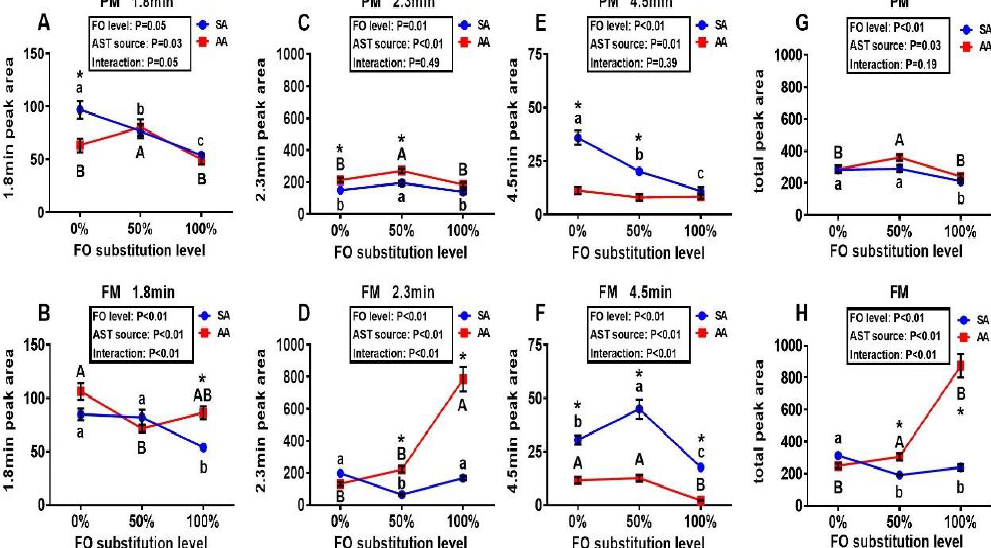
Figure 2. Effects of dietary fish oil substitution by DHA-rich microalgae and source of astaxanthin on relative areas of hepatic astaxanthin metabolite peaks ( A , B : 1.8 min; C , D : 2.3 min; E , F : 4.5 min; G , H : total of the three peaks) in juvenile rainbow trout fed the plant meal- (PM, A , C , E , G ) and fishmeal (FM, B , D , F , H )-based diets. Means labelled withdifferent letters [lowercase (a, b), synthetic astaxanthin (SA) groups; uppercase (A, B), microalgae astaxanthin (AA) groups] are different between various levels of fish oil substitution ( p < 0.05). Asterisks ( * ) indicate differences between SA and AA groups ( p < 0.05) at the same level of FO substitution. The absence of different letters (a, b, c or A, B) or asterisks ( * ) between means indicates no significant differences. FO: fish oil. AST: astaxanthin.